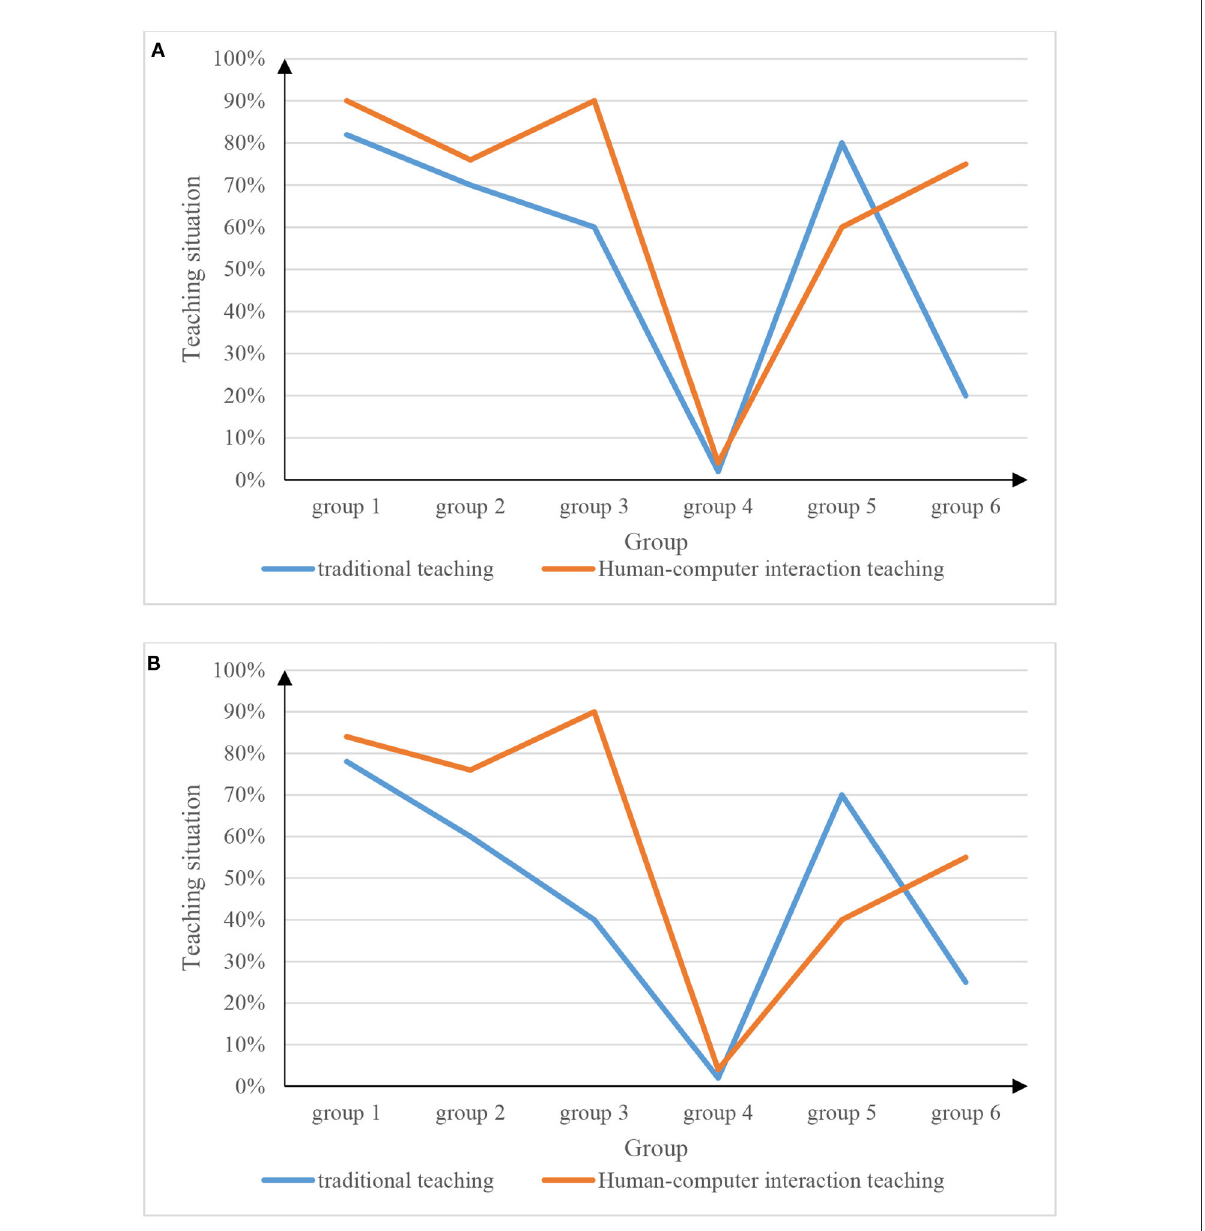
FIGURE8 Physical education teaching situation for boys and girls. (A) Physical education teaching situation for boys. (B) Physical education teaching situation for girls.